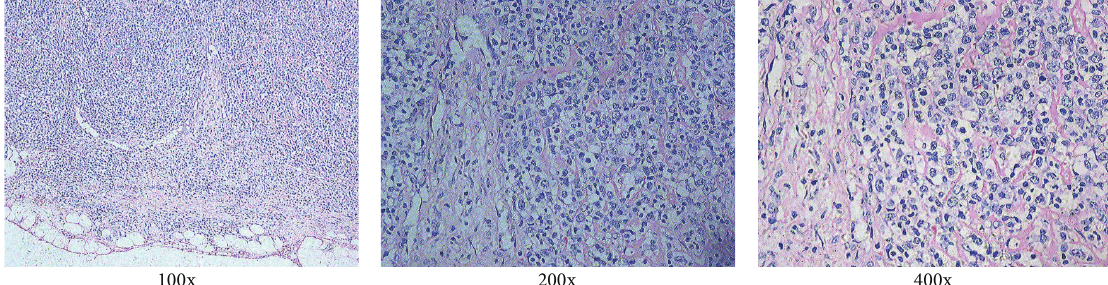
Figure 4: Pathology of PTLD. The pathology slides were stain of H&E by standard procedure. Pathology of PTLD was shown separately (100x, 200x and